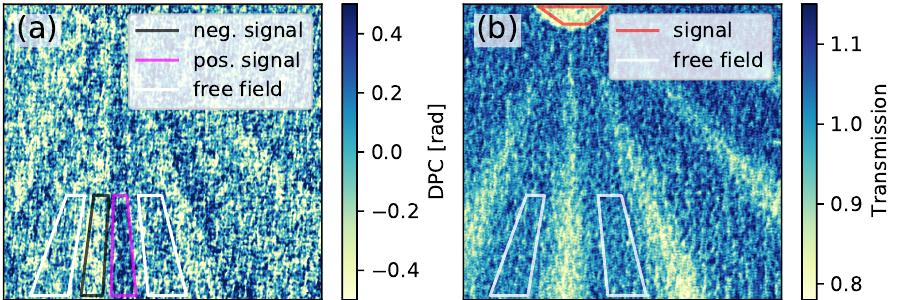
Figure 2. Reconstructed DPC ( a ) and transmission image ( b ) using the reference image one. Although the Moiré stripes are completely removable, the image is still noisy due to the low photon flux. The colored boxes mark the regions of interest (ROI) which are used for the evaluation process of the